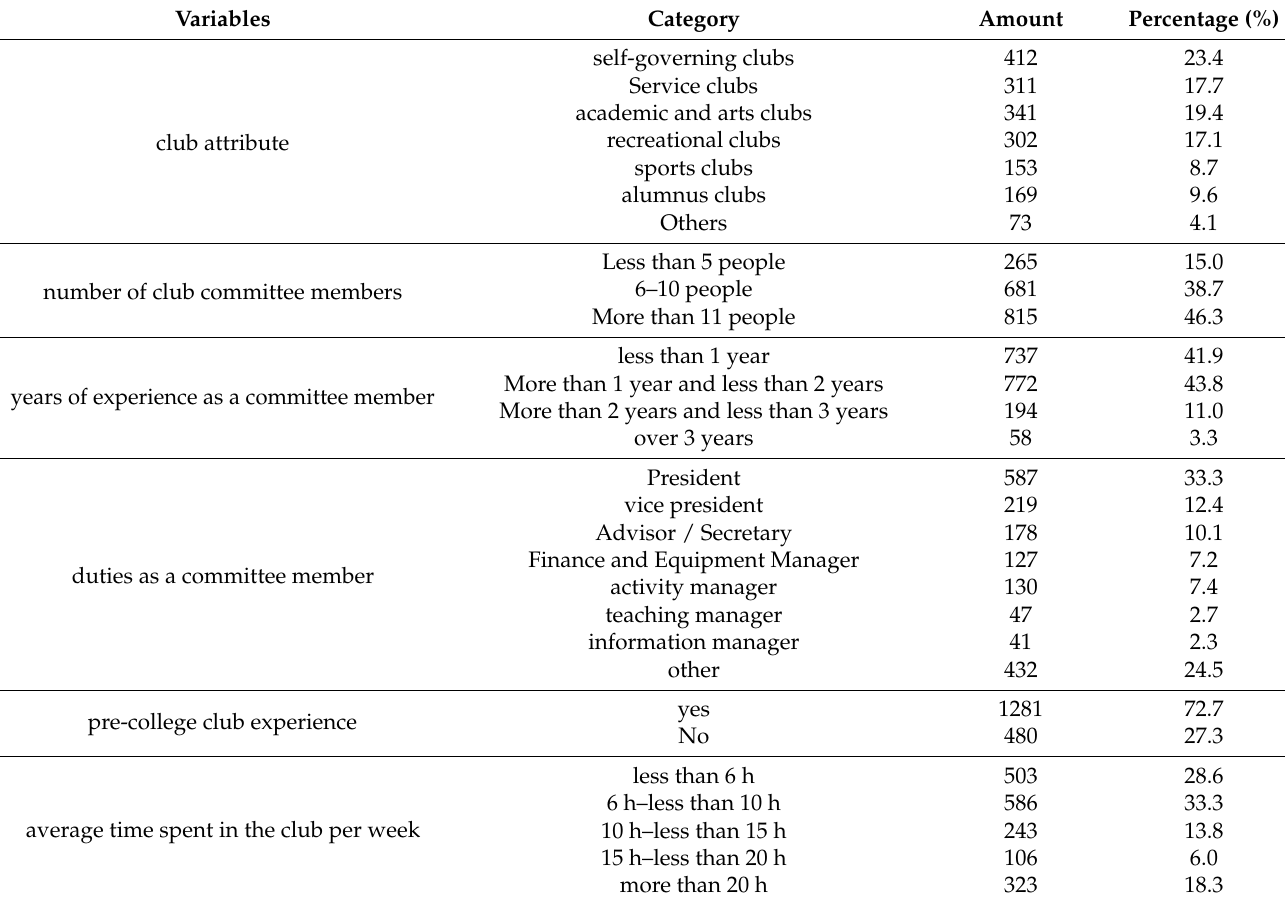
Table 4. Summary of Personal Background Information